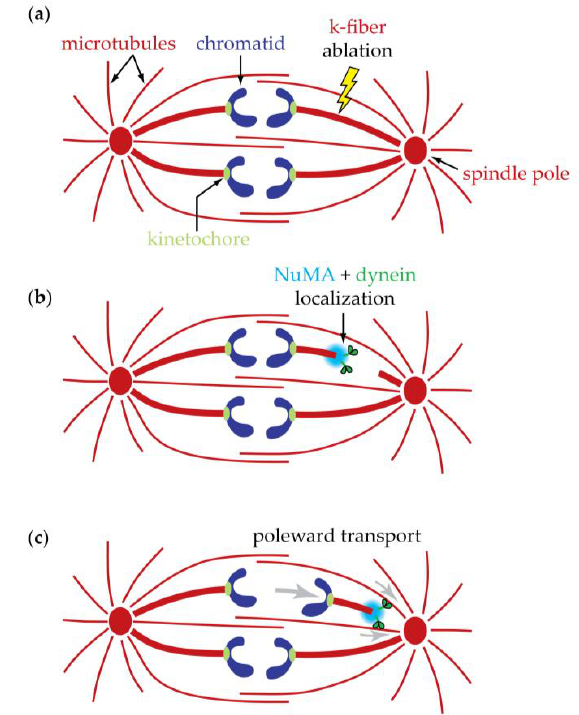
Figure 10. Spindle self-repair mechanism observed after micro-surgical ablation of kinetochore-associated microtubule fibers (k-fibers) in mammalian cells expressing fluorescent tubulin [60,61]. ( a ) Ablation of a k-fiber ( yellow lightning bolt ) during anaphase. ( b ) NuMA ( cyan ) and dynein/dynactin ( green ) rapidly localize to new microtubule minus ends on the k-fiber stub after ablation. ( c ) When the new minus end-localized dynein contacts neighboring microtubules, it walks processively along them, pulling the k-fiber stub as cargo and moving the attached chromosome. These diagrams are redrawn based on similar cartoons from [60], and are included here under the terms of a Creative Commons License (Attribution-Noncommerical-Share Alike 3.0 Unported license, as described at http://creativecommons.org/licenses/by-nc-sa/3.0/).